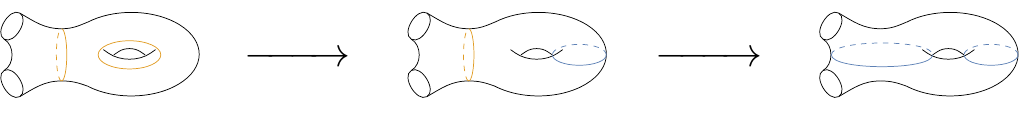
Figure 1 . The elementary crossing transformations: sphere four-point crossing between S and T channels, and torus one-point crossing between the (cid:28) and ( (cid:0) 1 =(cid:28) ) frames.